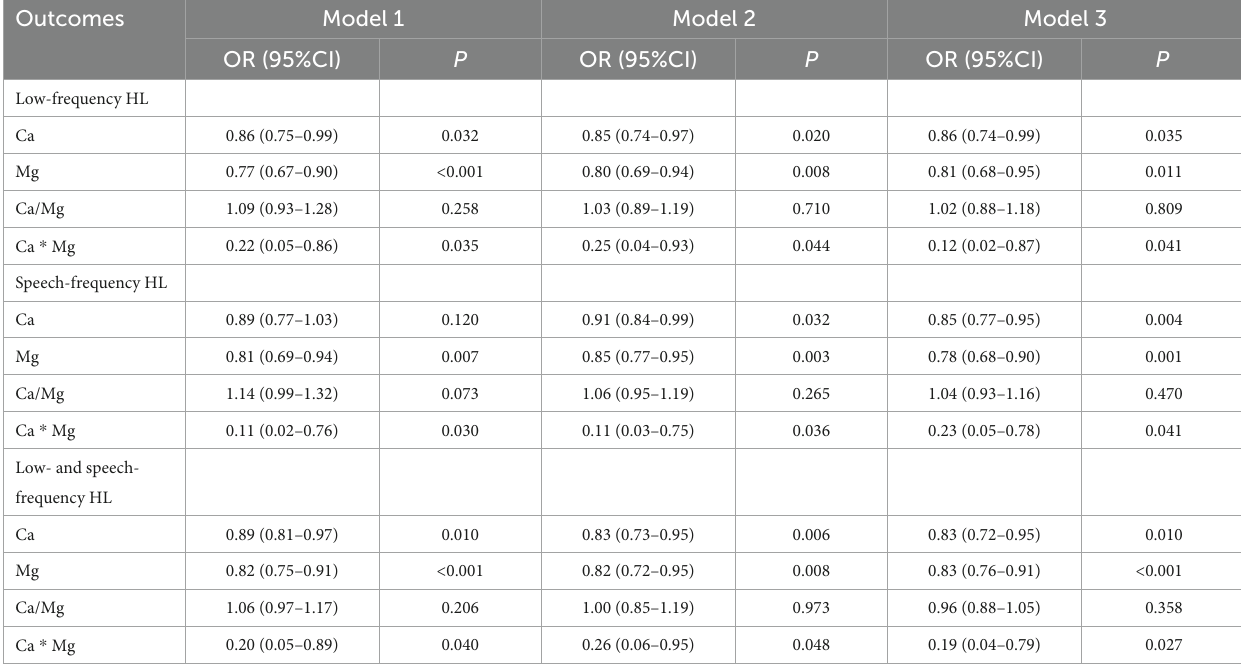
TABLE 2 Association of dietary calcium (Ca) and magnesium (Mg) intakes with hearing loss